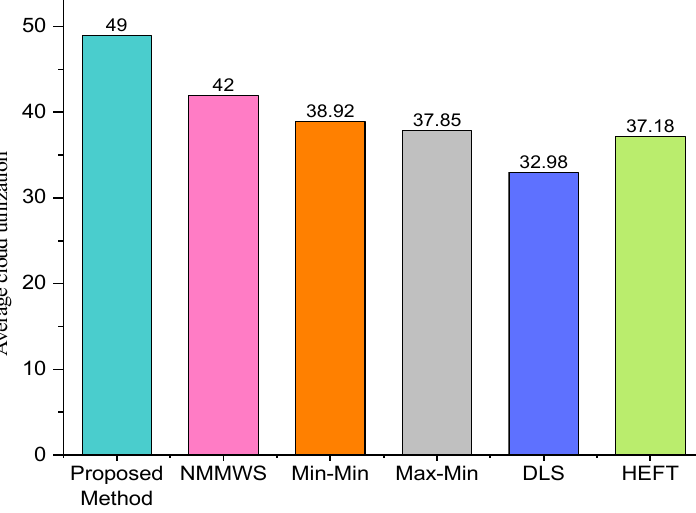
Figure 9. Average cloud utilization.